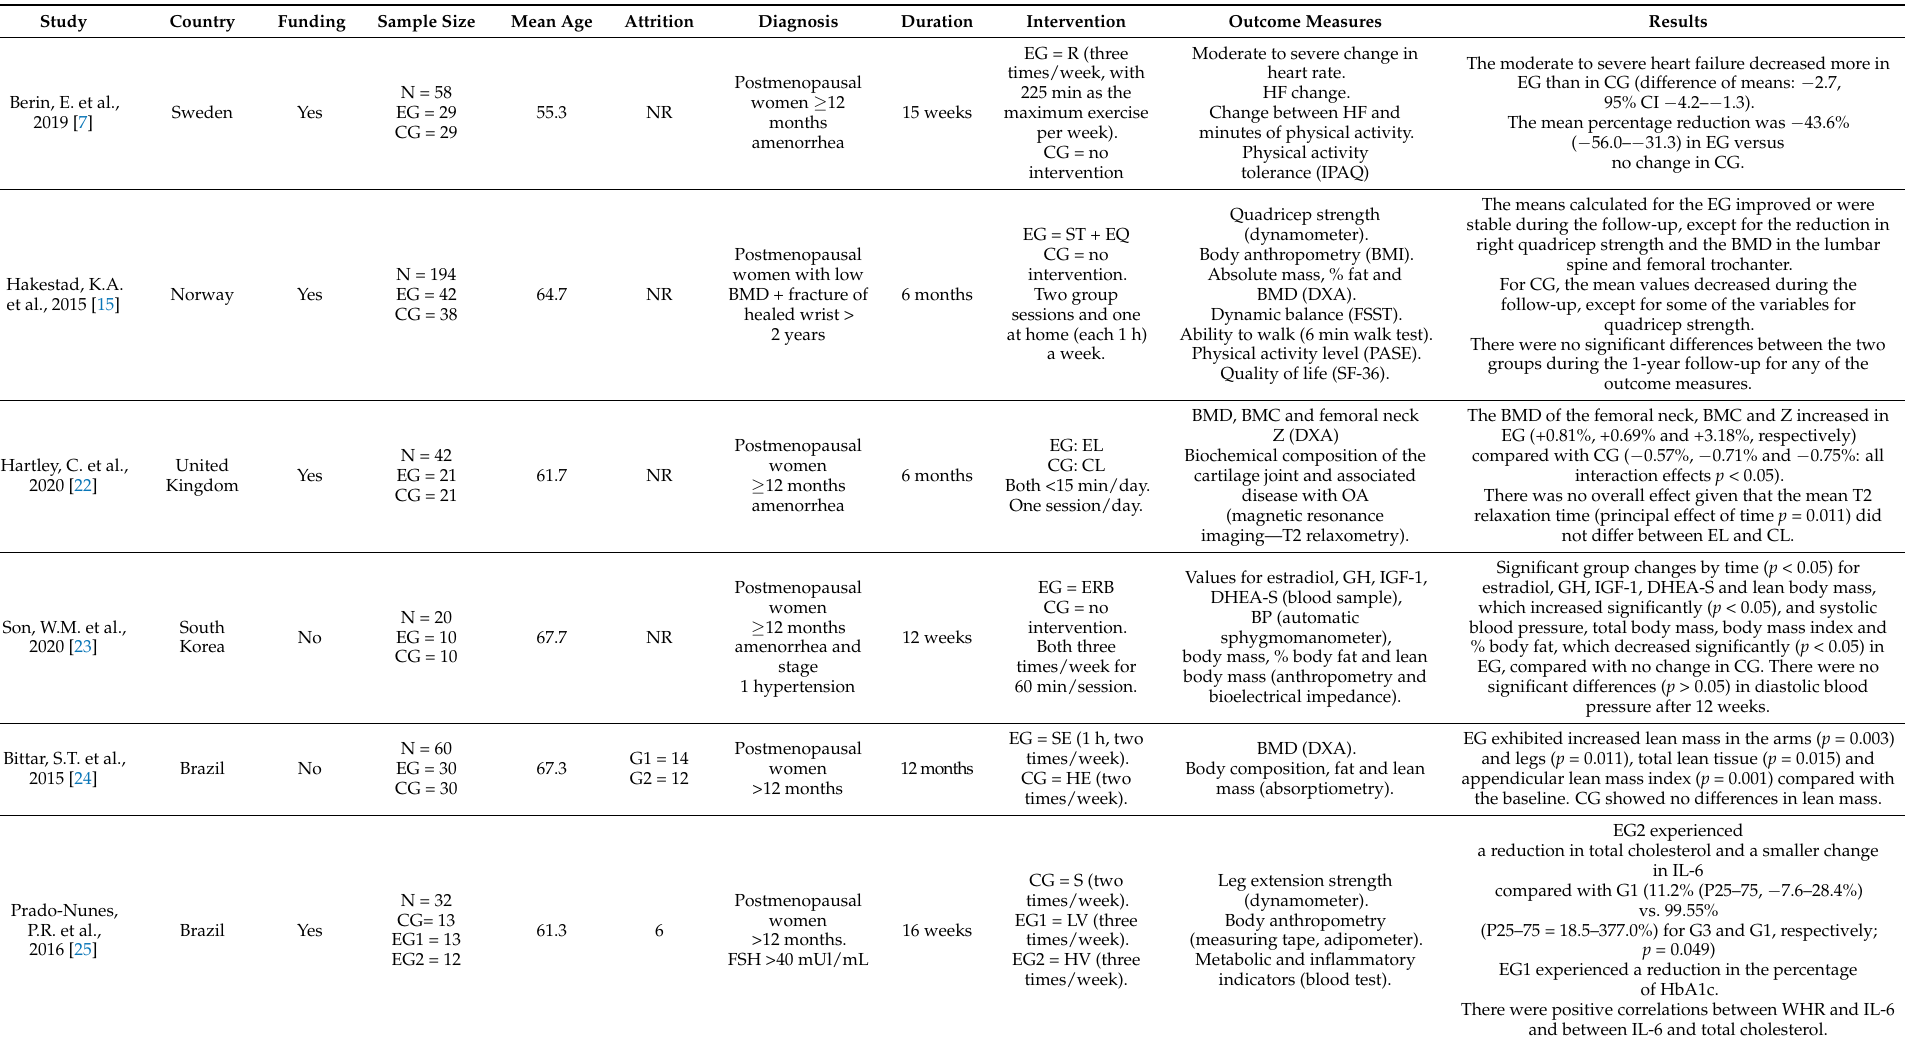
Table 1. Synthesis of Evidence for Strength Exercises on Symptoms of Postmenopausal